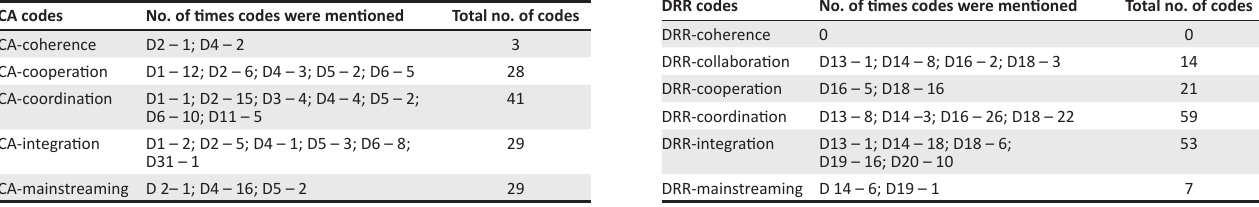
Content in climate change adaptation policies and legislation promoting